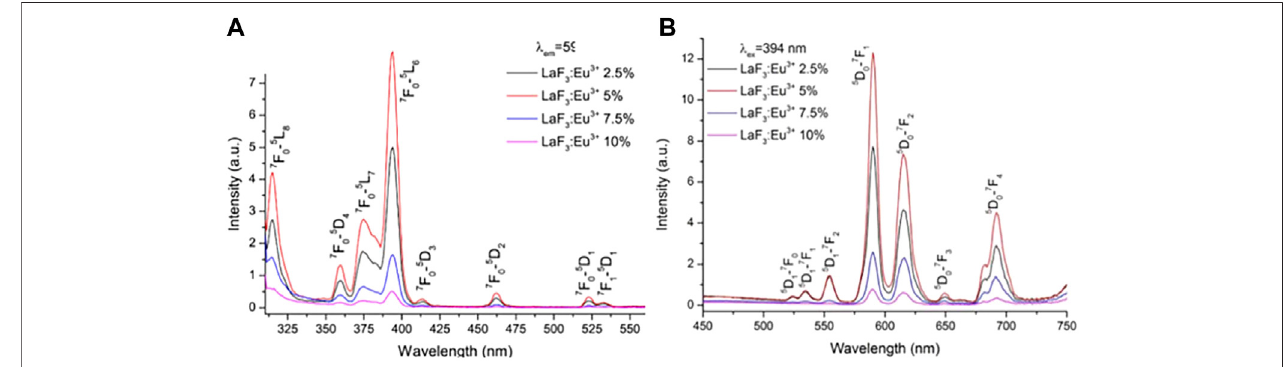
FIGURE 3 | Excitation spectra (A) and emission spectra (B) of LaF3:Eu 3+ with different Eu 3+ -doping concentration (Gulina et al., 2017).